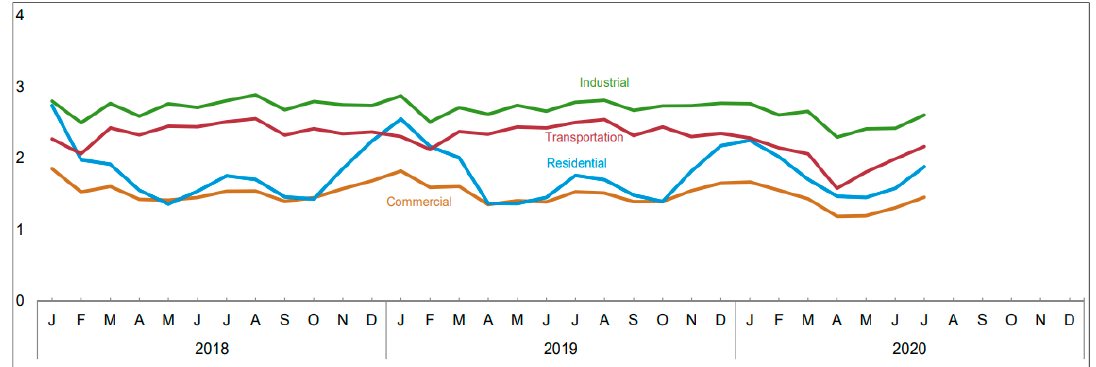
Figure 1. Energy consumption in various sectors from January 2018 to July 2020 (Unit: QuadrillionBtu) [1].